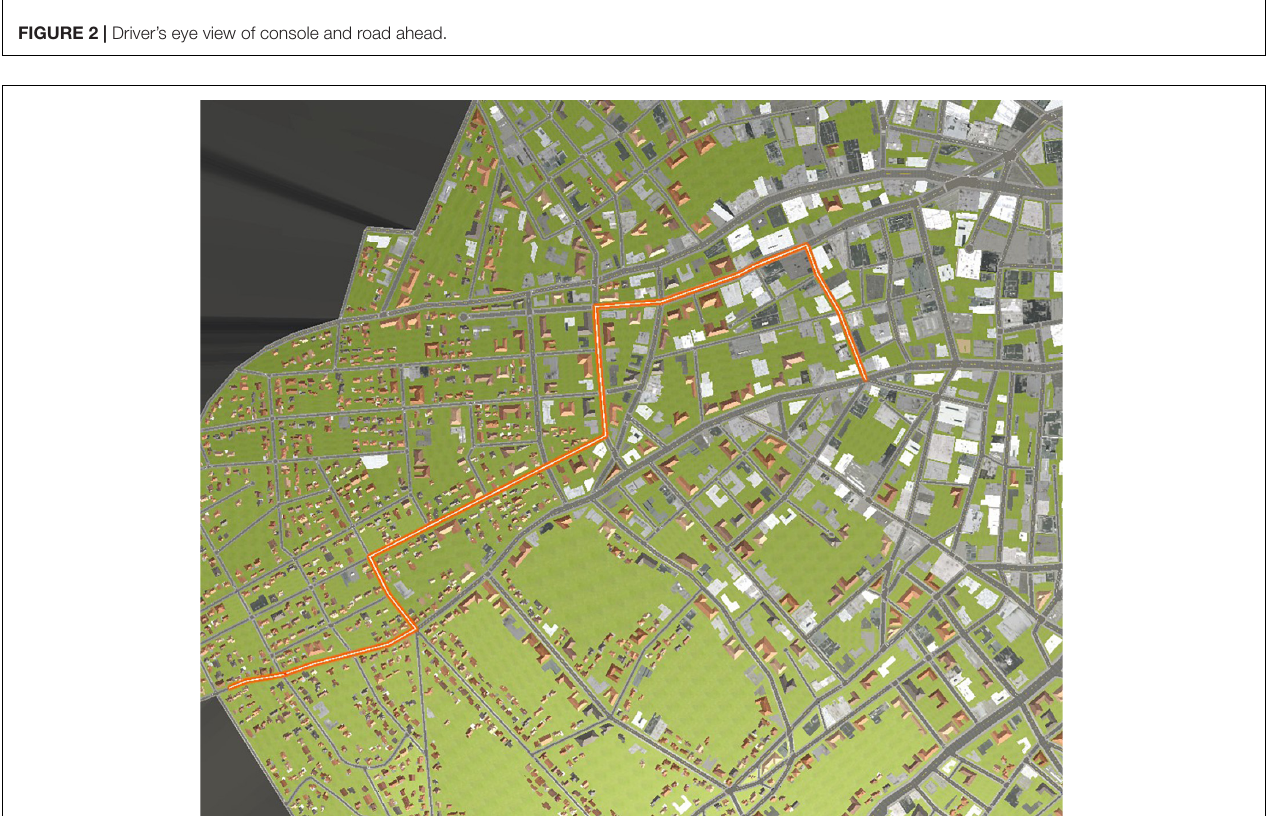
FIGURE 3 | Route A (start is in lower left of the